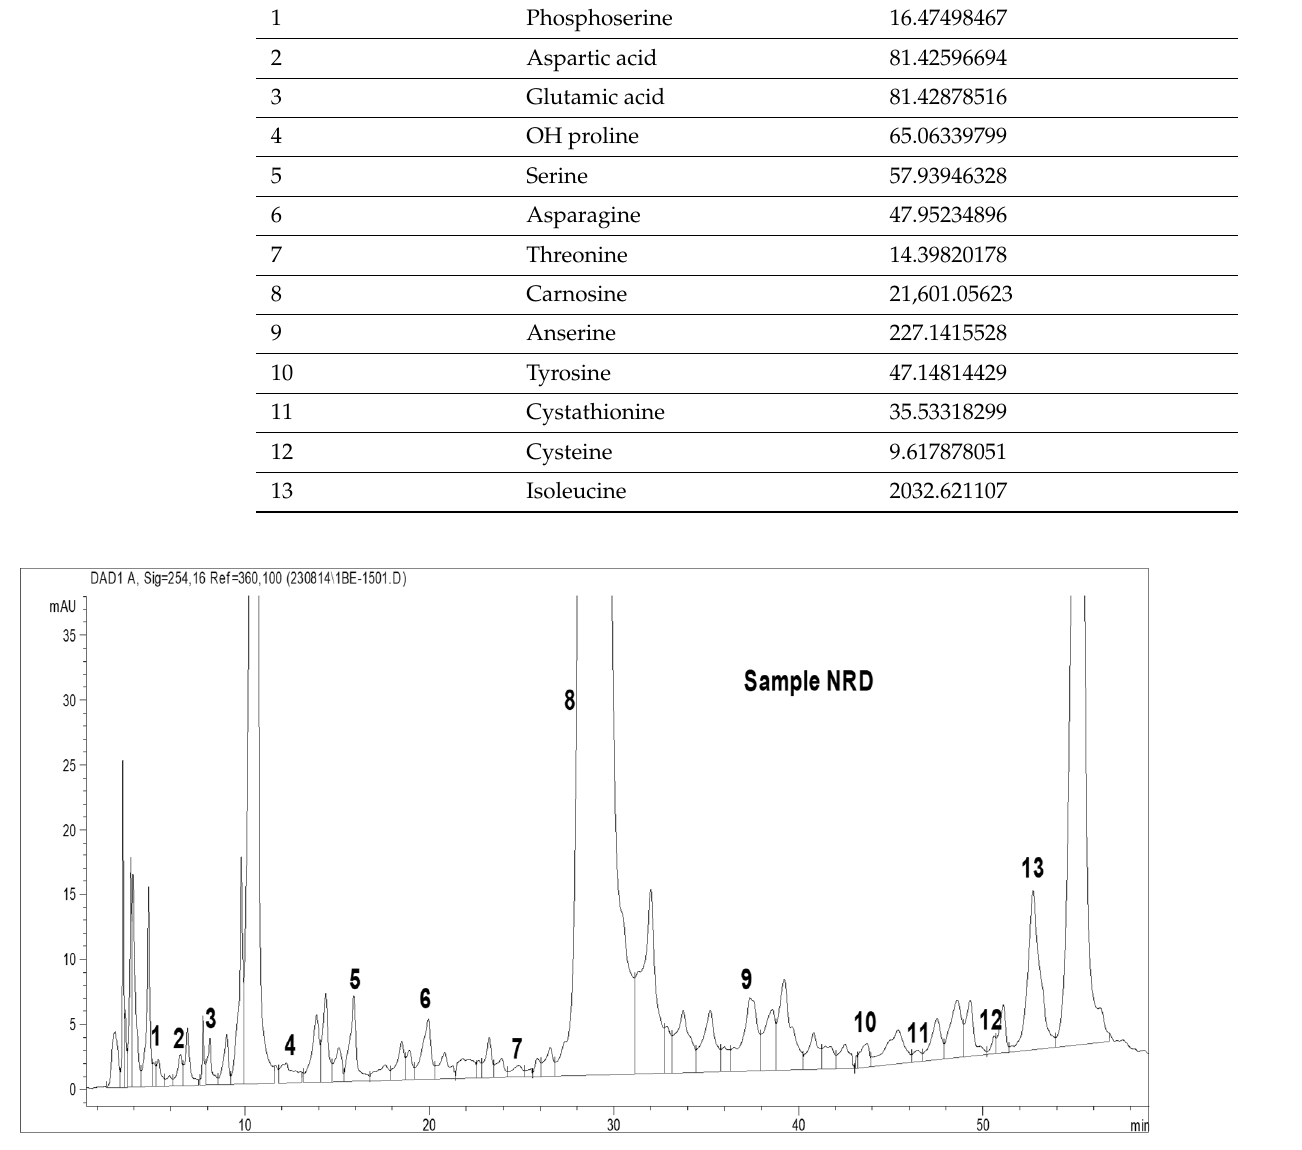
Figure 7. The peaks of the TAA content in R. faecalis N Raju MPPR (HPLC). Table 4. TAA content in R. faecalis N Raju MPPR (HPLC).